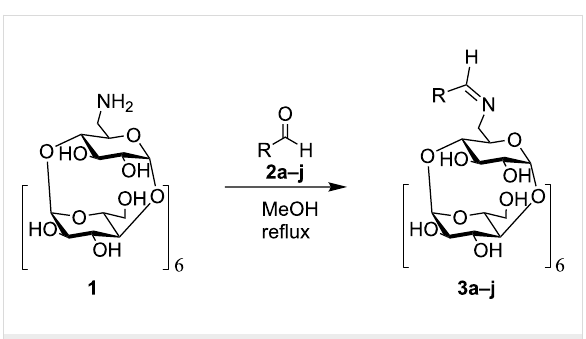
Figure 2: The common commercially available aldehydes used for binding to amino- β -CD ( 1 ): trans -cinnamaldehyde ( 2a ), cyclamen aldehyde ( 2b ), lilial ( 2c ), benzaldehyde ( 2d ), anisaldehyde ( 2e ), vanillin ( 2f ), hexanal ( 2g ), heptanal ( 2h ), citral ( 2i ), 5-methylfurfural ( 2j ).